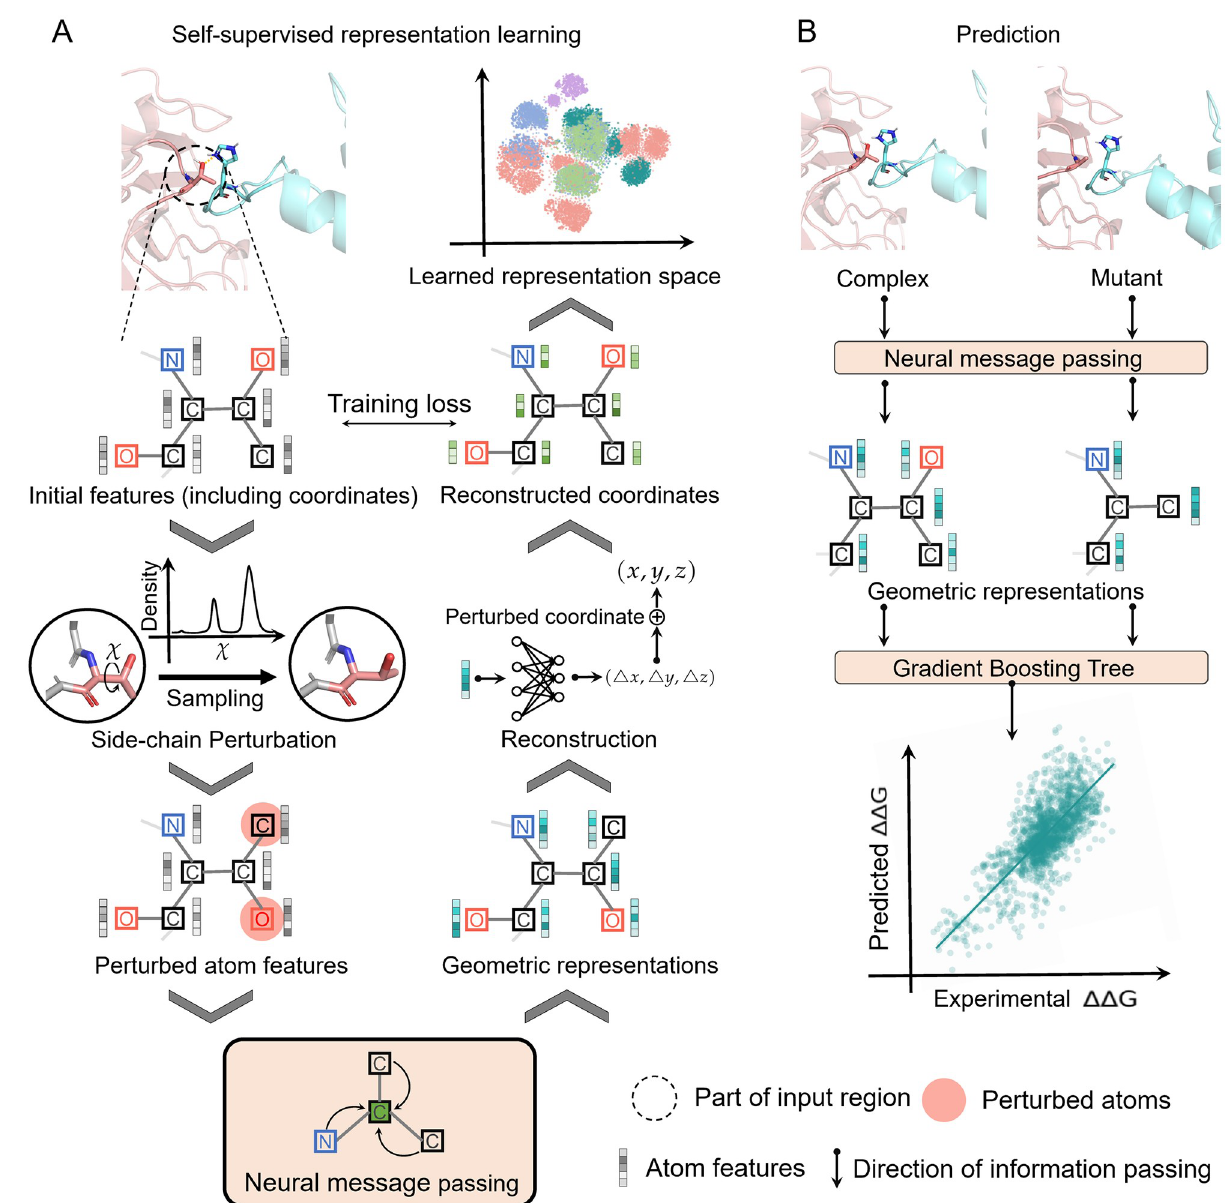
Fig 1. Schematic overview of the GeoPPI pipeline. (A) The self-supervised learning scheme, during which a geometric encoder learns to reconstruct the original structure of a complex given the perturbed one (where the side-chain torsion angles of a residue are randomly sampled). The geometric encoder is a neural network that performs the neural message passing operation on graph structures [19, 20]. The input of the geometric encoder is the graph structure of a complex, where we only consider the atoms that are no more than a predefined distance from either the mutated residues or the interface ones to reduce the computation complexity (Materials and methods). (B) The prediction process of GeoPPI, where the trained geometric encoder produces geometric representations for a given wild-type complex and a mutant, respectively, and a gradient boosting tree (GBT) takes these representations as input to predict the corresponding affinity